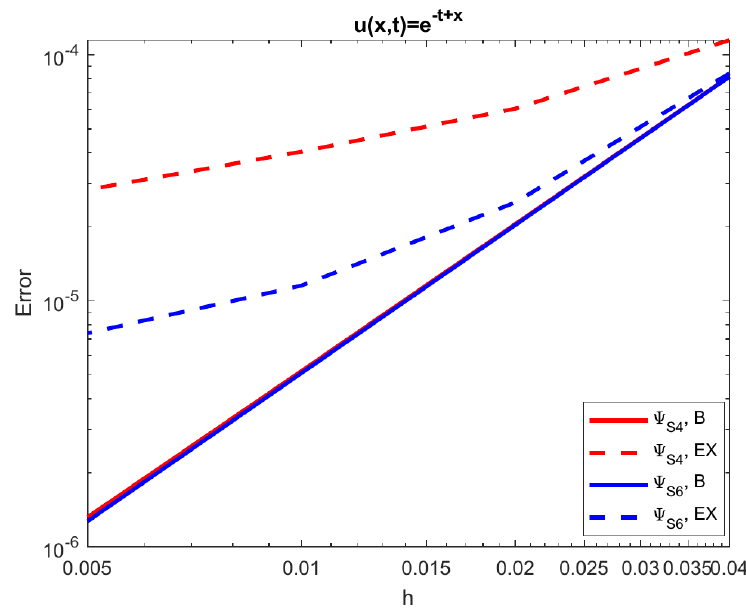
Figure 3. Error in energy norm for Test 3, N = 25,50,100,200 and h = k = 1/ N